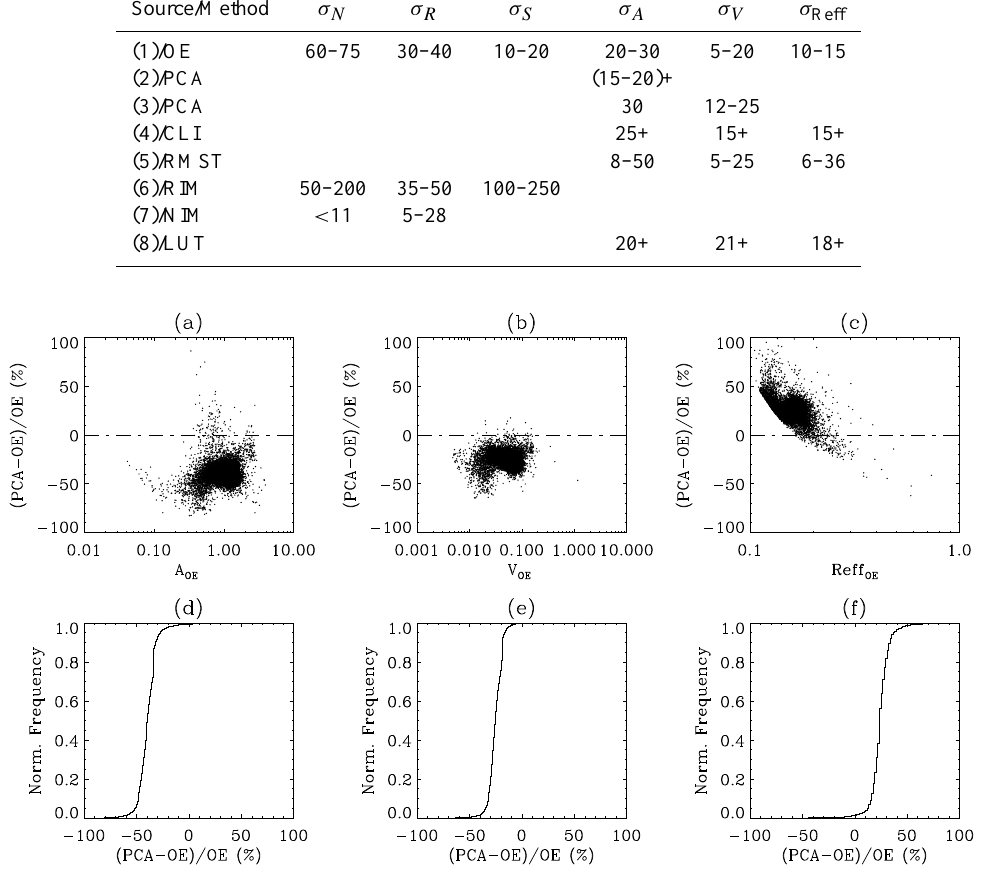
Fig. 13. Difference (in %) between the retrieved Optimal Estimation surface area densities ( A ), volume densities ( V ), and effective radii ( R eff ) and the Principal Component Analysis (PCA) results: (PCA-OE)/OE. Frames (a–c) : Difference as a function of A , V , R eff . Frames (d–f) : Cumulative histograms of the differences.